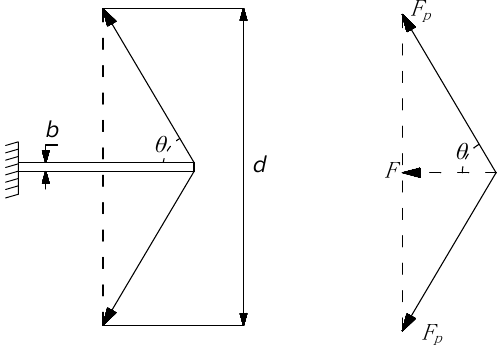
Figure 2. The force model and analysis of simulation.